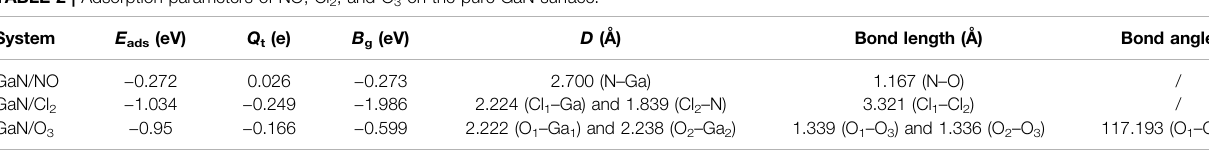
TABLE 2 | Adsorption parameters of NO, Cl 2 , and O 3 on the pure GaN surface. System